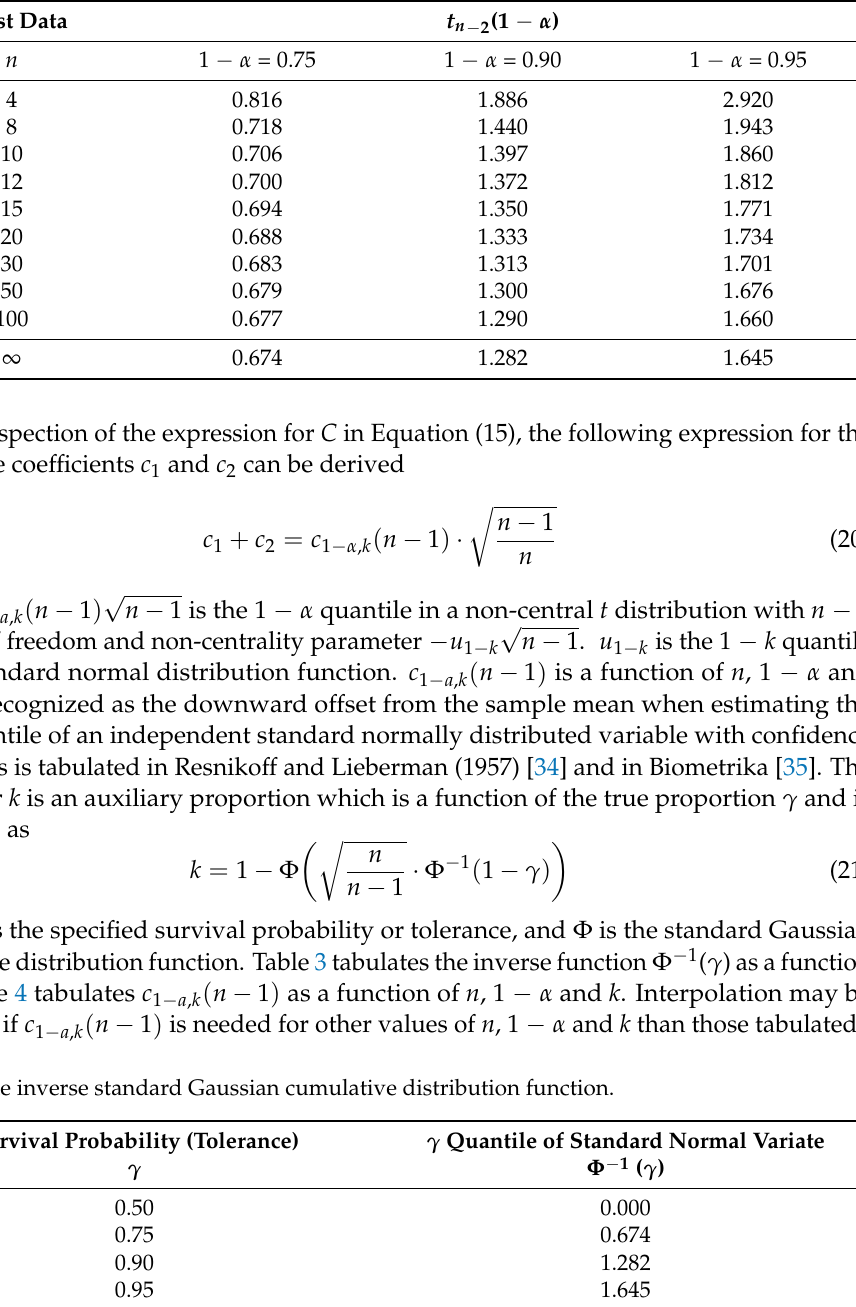
Table 2. Quantiles in the Student’s t distribution.